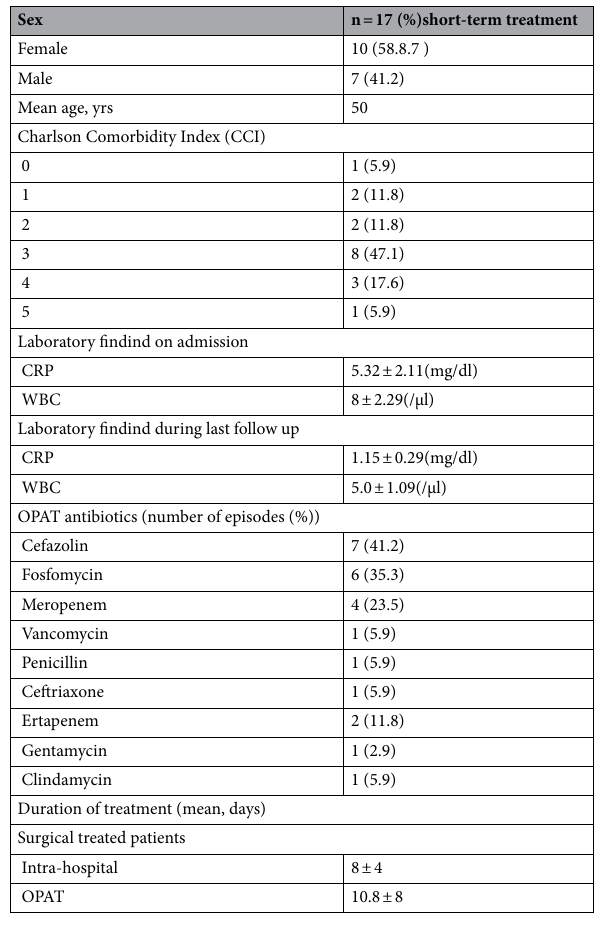
Table 2. Characteristics of outpatient parenteral antibiotic therapy for patients with short-term antimicrobial treatment.